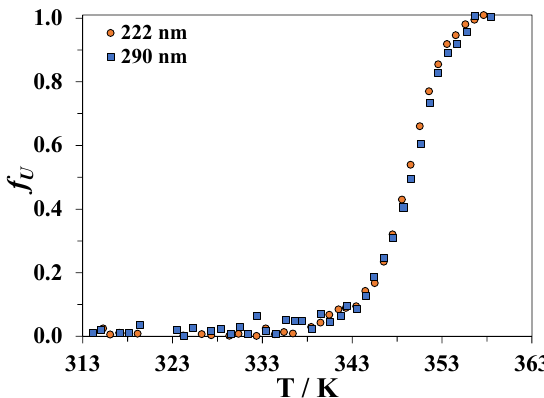
Figure 2. Dependence of the fraction f U of the lost secondary (CD signal measured at 222 nm) and tertiary (CD signal measured at 290 nm) structure of lysozyme in an aqueous solution as a function of temperature.